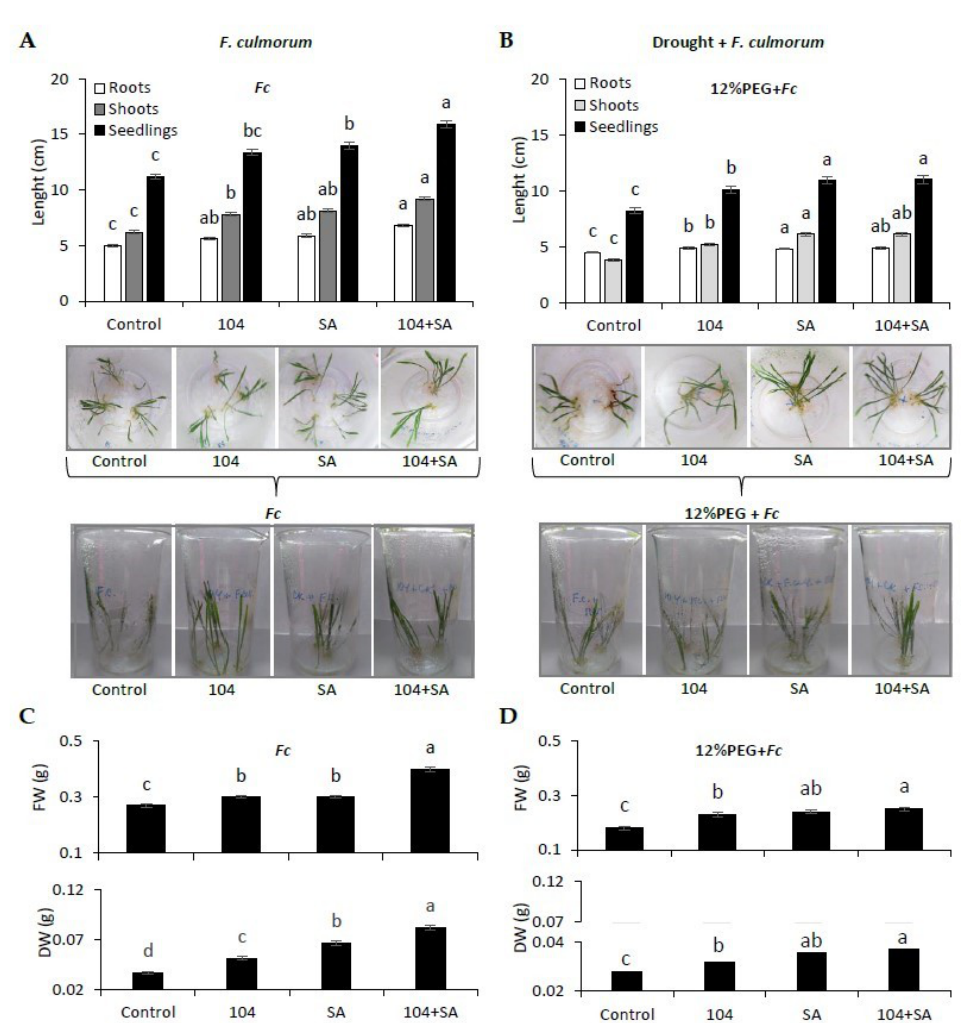
Figure 6. E ff ect of B. subtilis 10–4 (10 5 CFU mL − 1 ), SA (0.05 mM), and composition of B. subtilis 10–4 + SA on growth of wheat seedlings and their fresh weight (FW) and dry weight (DW) accumulation under the influence of F. culmorum ( Fc ) ( A , C ) and combined drought + F. culmorum (Drought + Fc ) ( B , D ) stresses. Fourteen-day-old seedlings; drought stress (12% PEG) exposure time—11 days; time after infection with F. culmorum —10 days. Control—plants without treatments; 104, SA, and 104 + SA—plants pretreated with B. subtilis 10–4, SA, and B. subtilis 10–4 + SA, respectively. The error bars show the average of three repetitions ± SEM ( n = 50). Di ff erent letters indicate a significant di ff erence between the average values for p < 0.05.